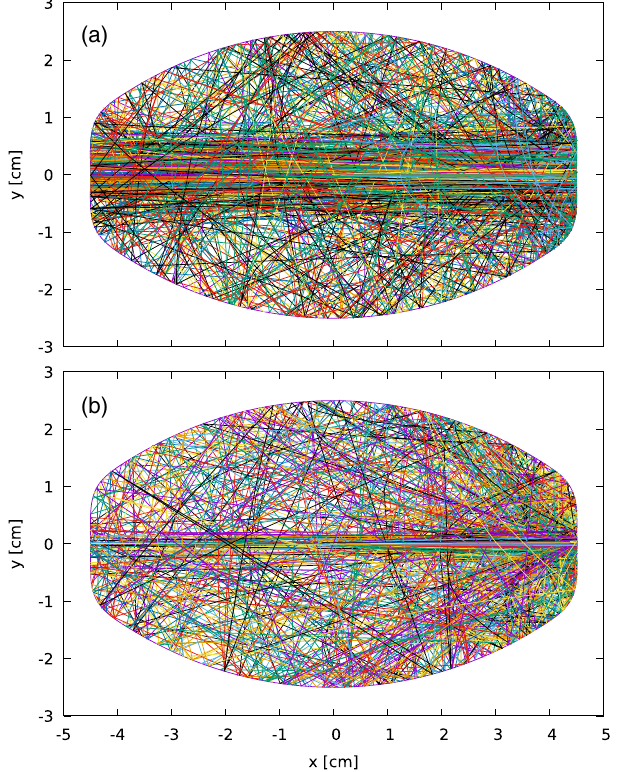
FIG. 6. Examples of photon trajectories (a) without the groove pattern on the vacuum chamber wall, and (b) with grooves. The groove pattern results in significantly enhanced scattering out of the horizontal midplane. The apparent curvature in the tracks is a consequence of the longitudinal bend in the reference trajectory in the dipole. (Beam energy is 5.3 GeV.)